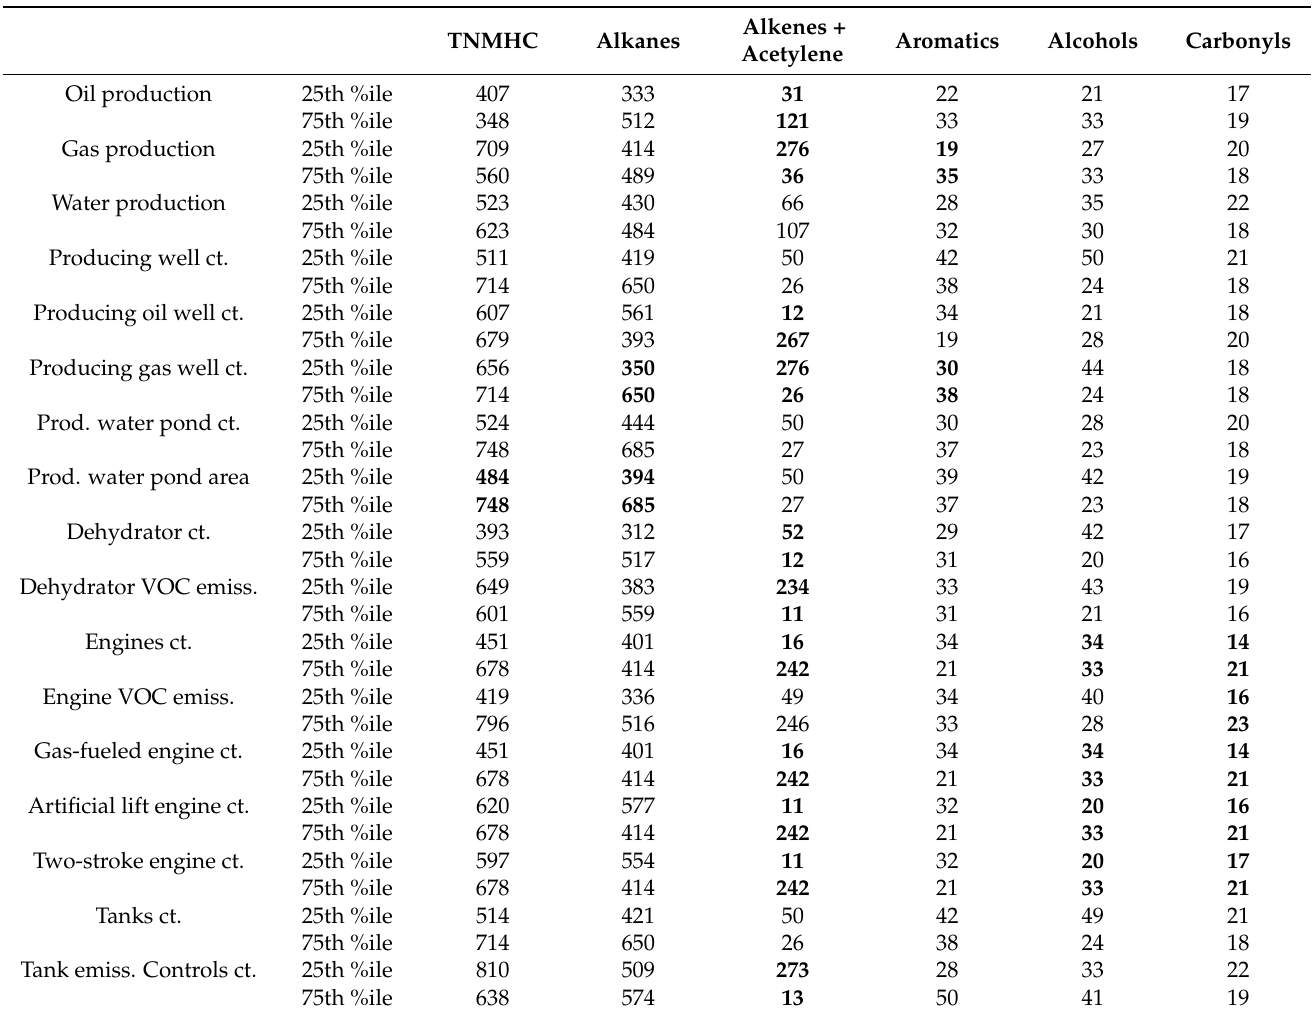
Table 1. Average concentrations of organic compound types ( µ g m − 3 ) for all sampling locations at which the sum of each listed oil and gas-related parameter within a 10 km radius was less than or equal to the 25th percentile or greater than or equal to the 75th percentile. Bold values are significantly different (Mann–Whitney test). Alkenes + Aromatics Alcohols Carbonyls TNMHC Alkanes Acetylene Oil production 25th %ile 407 Gas production Water production Producing well ct.